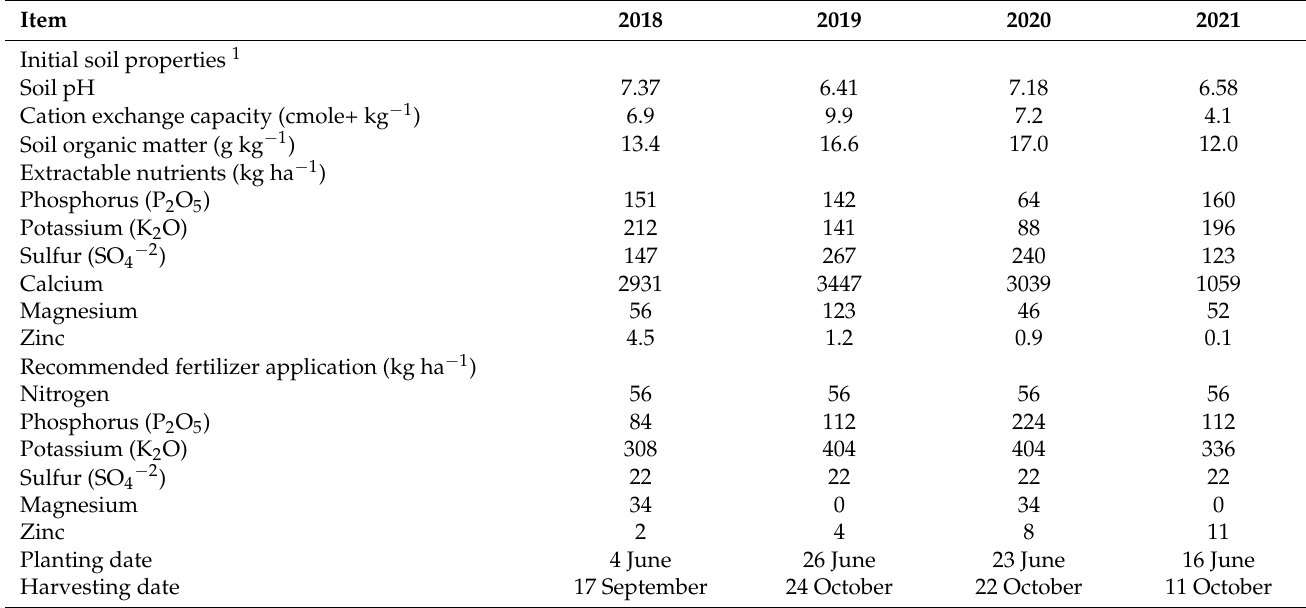
Table 1. Initial soil properties and recommended fertilizer rates based on soil testing results provided by a commercial laboratory at the Pontotoc-Ridge Flatwoods Branch Experiment Station, Pontotoc, MS during the 2018–2021 growing